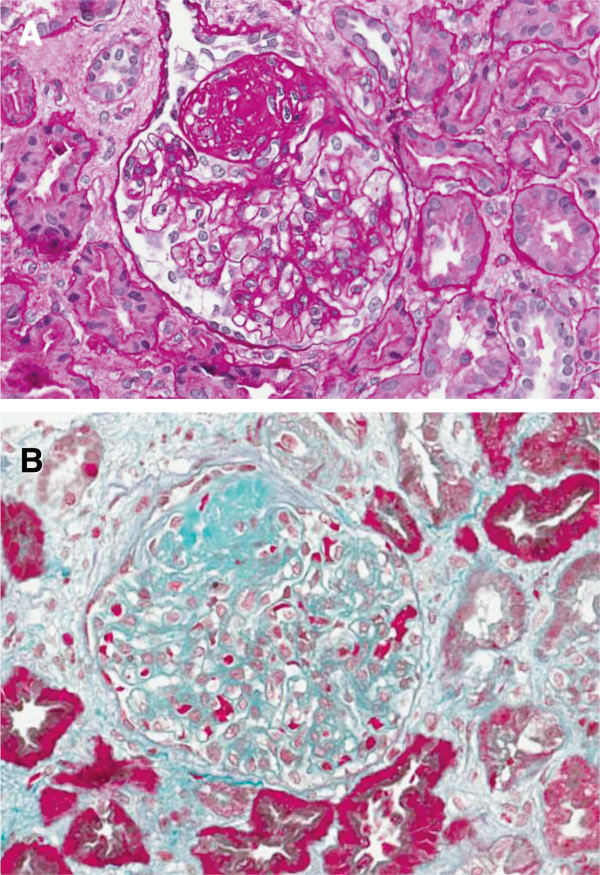
Renal histology of SIOD patient. Light microscopy images (A, B) showing larger glomerular volume, with a sclerotic lesion of the glomerular tuft. The remaining part of the glomerulus shows focal and segmental matrix increase and mesangial proliferation. Diffuse tubular atrophy and rare arteriolar ialinosis are also present (A: PAS staining, B: Masson’s Trichrome stain; ×400).